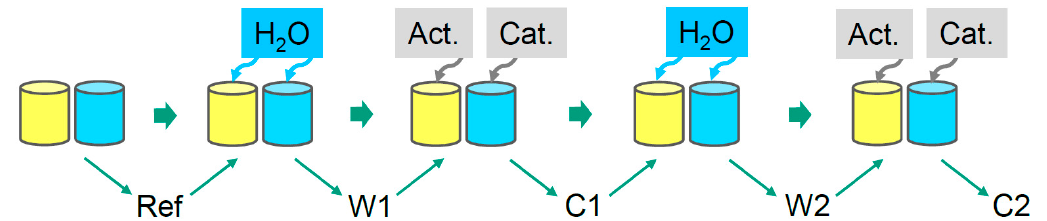
Figure 11. Order of water addition and compensation procedure.